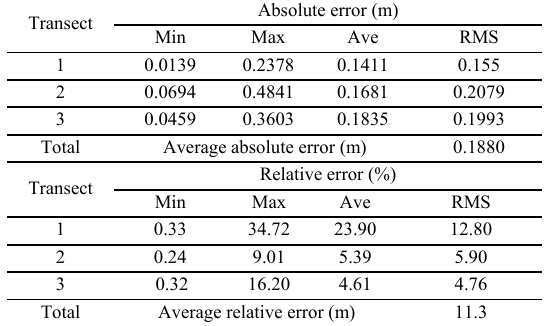
Table.2 Statistic analysis of relative and absolute error between inversion and RTK